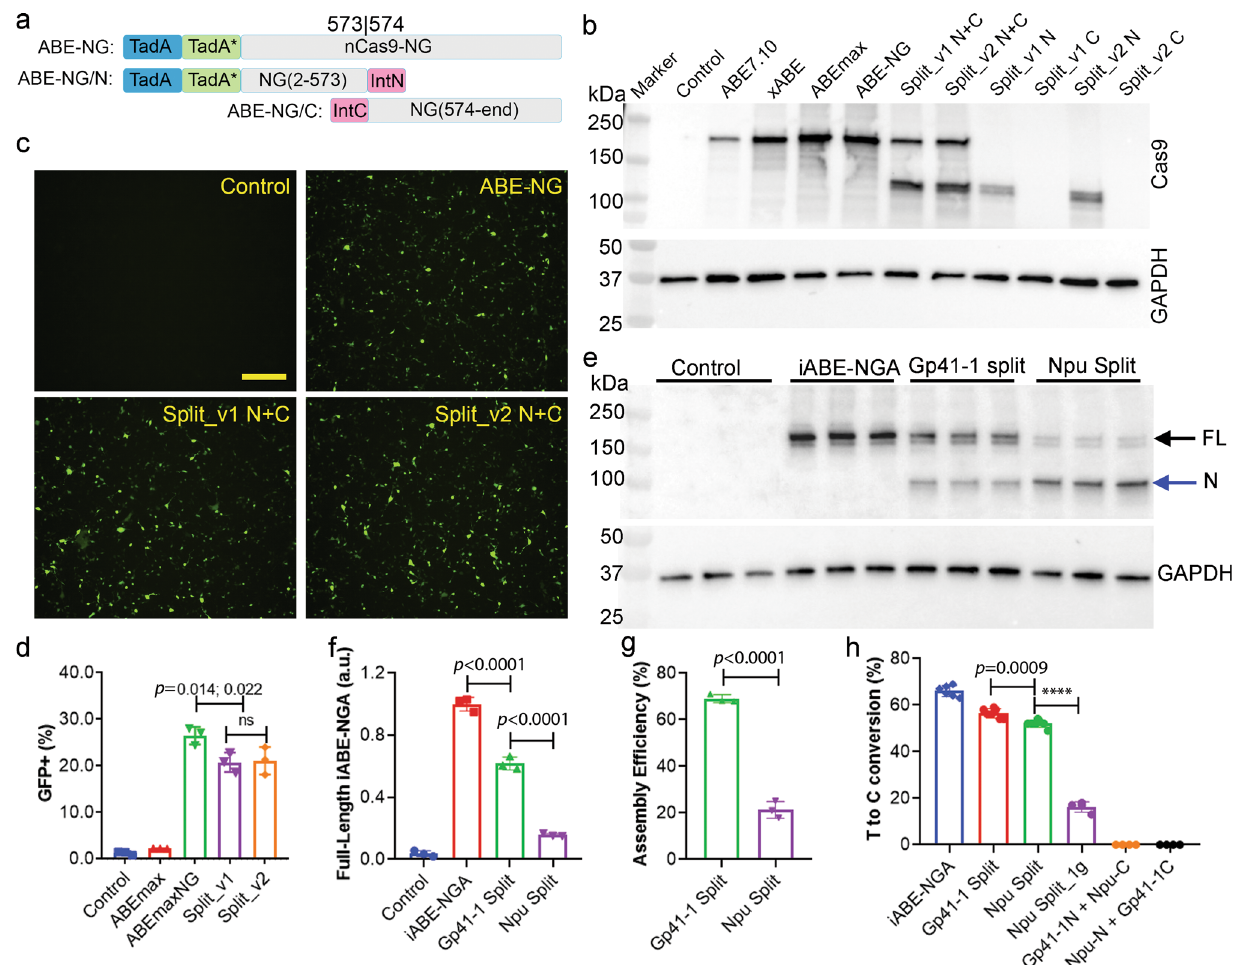
Fig. 4 Intein-mediated assembly of full-length ABE-NG. a Schematics of the intein split ABE-NG. The N-terminal and C-terminal intein sequences reconstitute the full-length protein when co-expressed within cells. b Western blot analysis of HEK293 cell lysates transfected with different versions of ABEs. c Fluorescence microscopy images of HEK293 cells transfected with reporter alone, or reporter, gRNA and one of the base editors (ABE-NG, split_v1 N + C or Split_v2 N + C). Scale bar: 500 µ m. d Flow cytometry analysis of EGFP expression in HEK293 cells transfected as described in ( c ). n = 3 wells/ group; ns not signi fi cant; one-way ANOVA with Turkey ’ s multiple comparisons test. Data are mean ± SD. e Western blot analysis of HEK293 cell lysates transfected with full-length iABE-NGA, Gp41-1, or Npu split of iABE-NGA. FL, the full-length iABE-NGA band; N, the N-terminal fragment of the iABE-NGA. f Densitometry quanti fi cation of the Western blot data shown in ( e ). n = 3 wells/group; one-way ANOVA with Turkey ’ s multiple comparisons test. Data are mean ± SD. g The assembly ef fi ciency of the Gp41-1 and Npu split of iABE-NGA (de fi ned as the percentage of the full-length iABE-NGA bands). n = 3 wells/group; one-way ANOVA with Turkey ’ s multiple comparisons test. Data are mean ± SD. h Quanti fi cation of the editing ef fi ciency of full-length iABE- NGA, Gp41-1 split, and Npu split of iABE-NGA at the mdx 4cv target site. Npu Split_1g is same as Npu Split except that only the C-terminal construct carries the gRNA. n = 6 wells/group for iABE-NGA; n = 7 for Gp41-1 Split and Npu Split; n = 3 wells/group for Npu Split_1g, Gp41-1N + Npu-C, and Npu-N + Gp41-1C; **** p < 0.0001; one-way ANOVA with Turkey ’ s multiple comparisons test. Data are mean ±